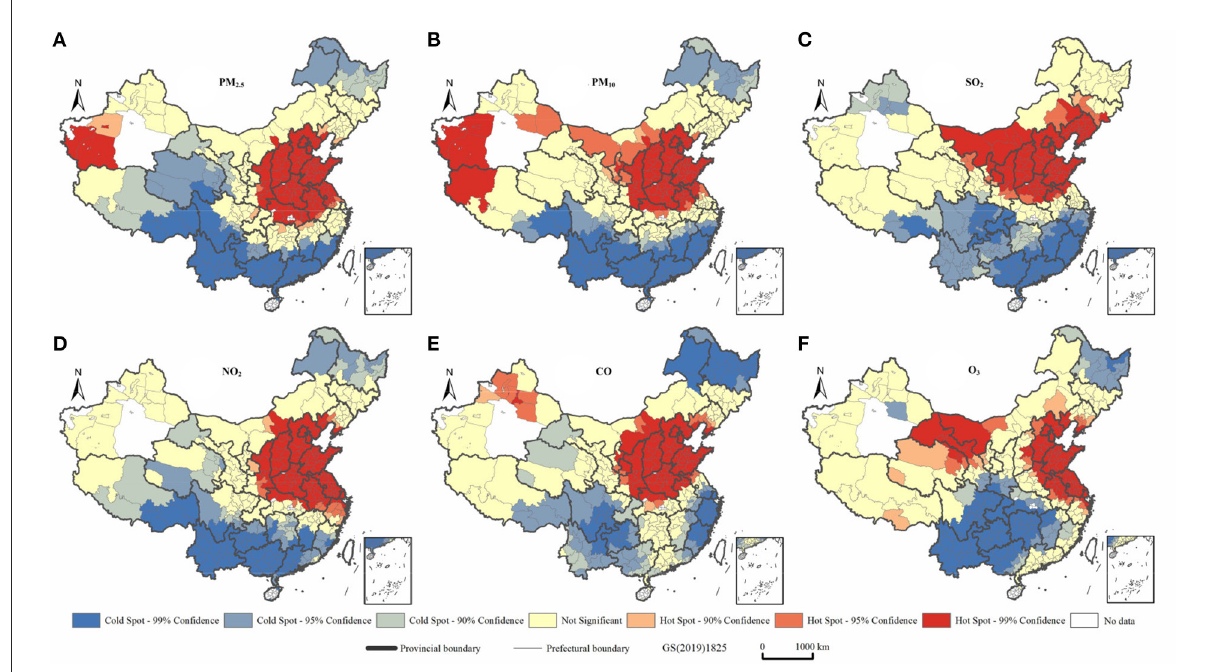
FIGURE4 Analysis of six types of air pollutants in China during the period 2014-2017 using the local Getis-Ord Gi * statistic. (A) PM 2.5 . (B) PM 10 . (C) SO 2 . (D) NO 2 . (E) CO. (F) O 3 .